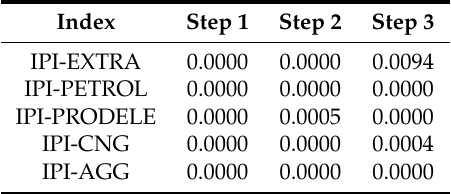
Table 27. Modified Diebold–Mariano statistics for the equality of forecast accuracy of two forecasts under general assumptions with expanding window from 2008:01 to 2018:12. The null hypothesis is that the two methods have the same forecast accuracy. The loss function is the absolute error.